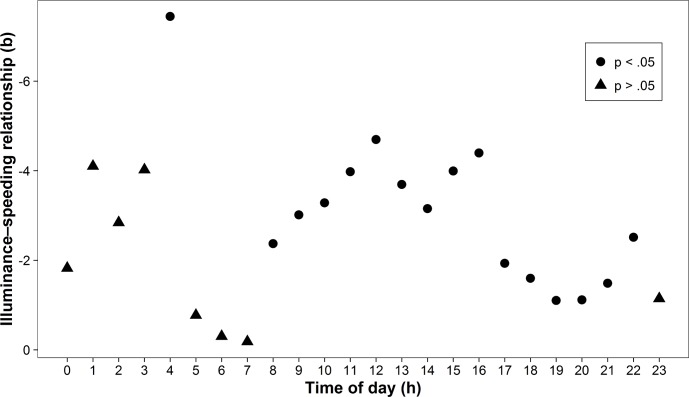
The illuminance‒speeding relationship by time of day.We calculated separate regression analyses for each hour of the day. The y-axis indicates non-standardized regression coefficients and is reversed for ease of interpretation (i.e., higher numbers indicate a stronger negative relationship). Time of day corresponds to the local time (UTC+1 adjusted for daylight saving time). The illuminance‒speeding relationship was particularly strong after noon and was (with one exception) non-significant at night, when traffic volume reaches its daily minimum.